Question: According to the figure, is the described quantity increasing or decreasing?
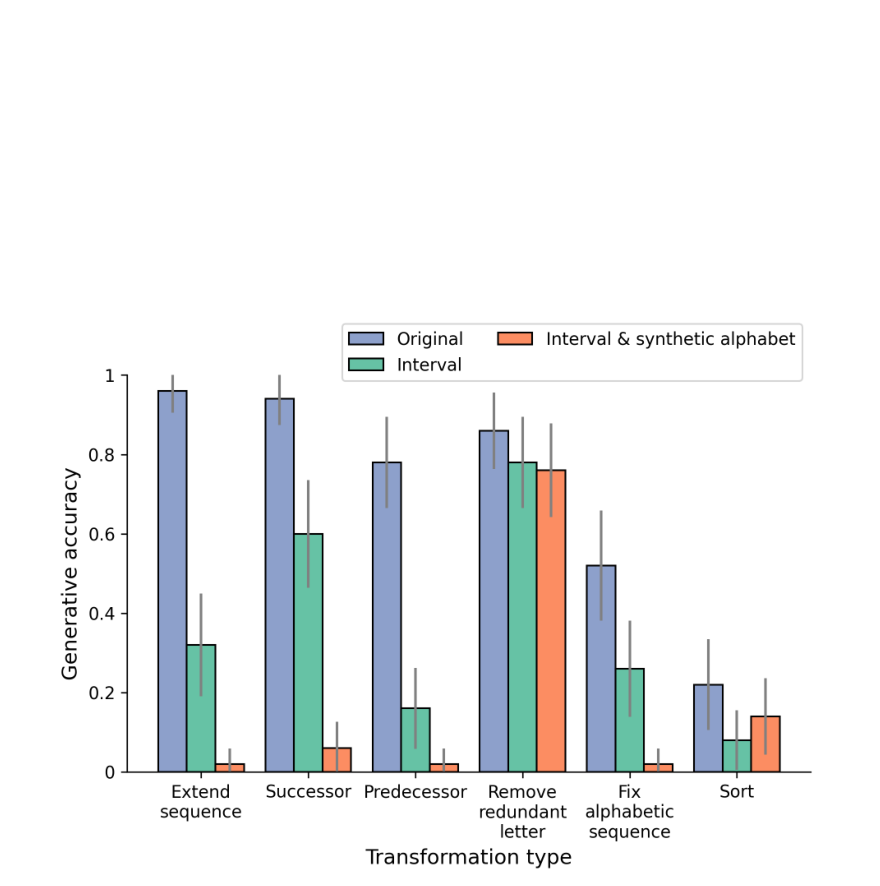
Answer: decreasing